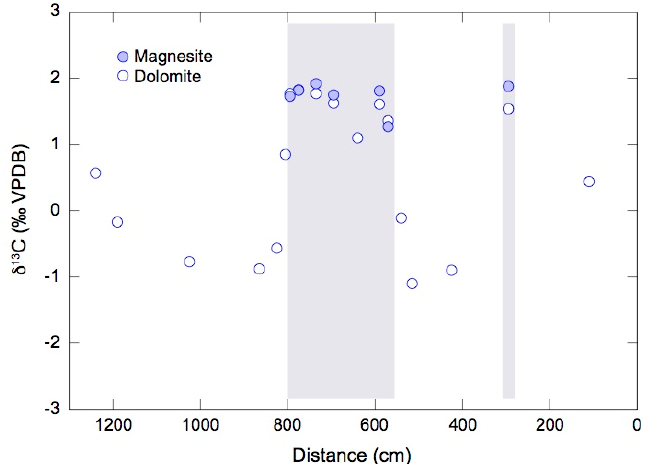
Figure 5. Transect of carbon isotope ratios of magnesite and dolomite across the south wall of the Dobbie mine. Gray shows location of magnesite ore.